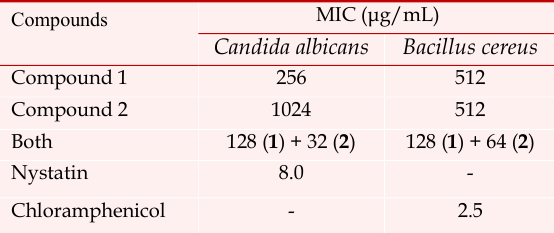
The antimicrobial activity of the isolated compounds was evaluated against Candida albicans and Bacillus cereus (Teh et al., 2013). Compound 1 showed moderate effect with MIC values of 256 μ g/mL and 512 μ g/mL, respectively (Table I). Interestingly, the growths of the microorganism were completely inhibited when treated with the combination of 1 (128 μ g/mL) and 2 (32 μ g/ mL for C. albicans and 64 μ g/mL for B. cereus ).